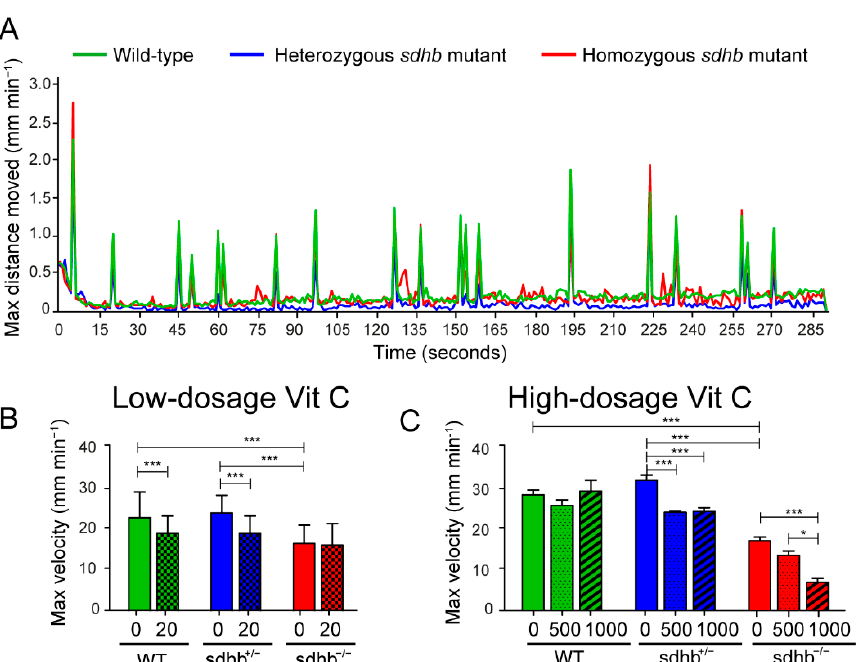
Figure 5. Startle response measurements at basal level and after low- and high-dosage levels of Vitamin C. ( A ) Optimized short protocol (<5 min in total) to quickly assess startle responses as a toxicity indicator induced by tapping stimuli with random intervals varying between 2 and 35 s. The max distance moved (mm min − 1 ) is plotted against time per seconds. Between the wild-type (green line) and heterozygous mutants (blue line), no differences were observed, while homozygous sdhb mutants (red line) showed a decrease in moved distance. ( B ) Quantification of the average of the maximum velocity of three startle responses with or without the supplementation of low-dosage levels of Vitamin C (20 mg ⋅ L − 1 ). Low-dosage levels of Vitamin C decreased the startle response of wild-type and heterozygous sdhb larvae while not affecting homozygous sdhb larvae. Larvae were supplemented with 20 mg ⋅ L − 1 Vitamin C homozygous sdhb ( n = 106), heterozygous sibling ( n = 244), and wild-type sibling ( n = 137) compared to the control group (indicated with 0 mg ⋅ L − 1 ) consisting of homozygous sdhb larvae ( n = 91), heterozygous sibling ( n = 227), and wild-type sibling ( n = 100) from five different replicates measured at 6 dpf. ( C ) Quantification of the average of the maximum velocity of three startle responses with or without supplementation of high-dosage levels of Vitamin C (500 and 1000 mg ⋅ L − 1 ). Both 500 and 1000 mg ⋅ L − 1 concentrations of Vitamin C induced a decreased startle response in heterozygous sdhb larvae, while only the 1000 mg ⋅ L − 1 concentration of Vitamin C induced a decreased startle response in homozygous sdhb larvae and none of the high-dosage levels of Vitamin C significantly altered the startle response of the wild-type larvae. Larvae were supplemented with 500 mg ⋅ L − 1 Vitamin C homozygous sdhb ( n = 73), heterozygous sibling ( n = 139), and wild-type sibling ( n = 55), 1000 mg ⋅ L − 1 Vitamin C homozygous sdhb ( n = 20), heterozygous sibling ( n = 37), and wild-type sibling ( n = 19) compared to the control group (indicated with 0 mg ⋅ L − 1 ) consisting of homozygous sdhb larvae ( n = 32), heterozygous sibling ( n = 48), and wild-type sibling ( n = 40) from at least two different replicates measured at 6 dpf. One-way ANOVA with Tukey’s post hoc test, * p < 0.05 and *** p < 0.001.